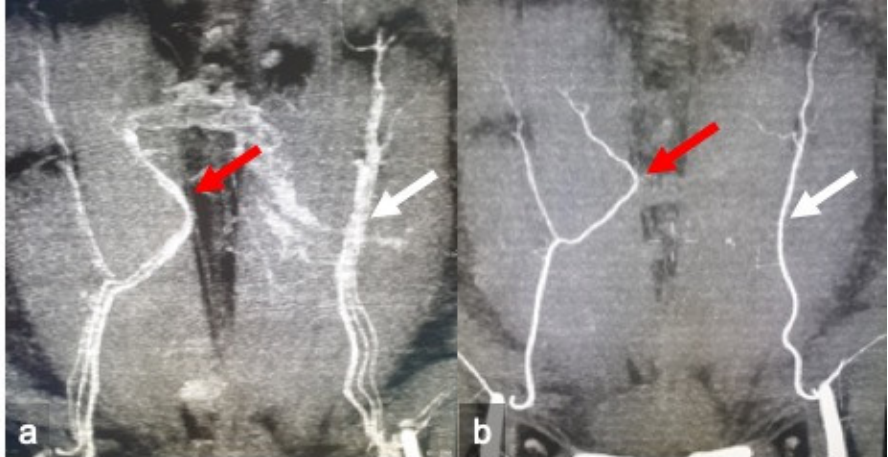
Figure 4. Identification of the deep inferior epigastric artery branching according to Taylor’s classification. cCT ( a ) and CTa ( b ) oblique-coronal sub-volume maximum intensity projection reconstruction (MIP) of the superficial abdominal wall revealed a bifurcated artery on the right hemi-abdomen (red arrows) and a single on the left (white arrows).